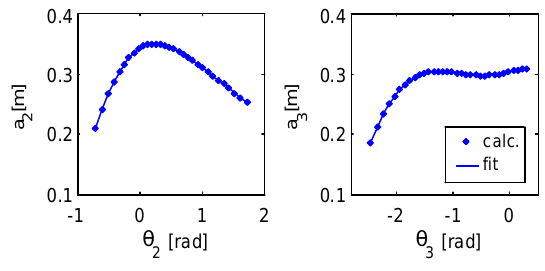
Figure 11: Effective torque arms of cylinder 2 and